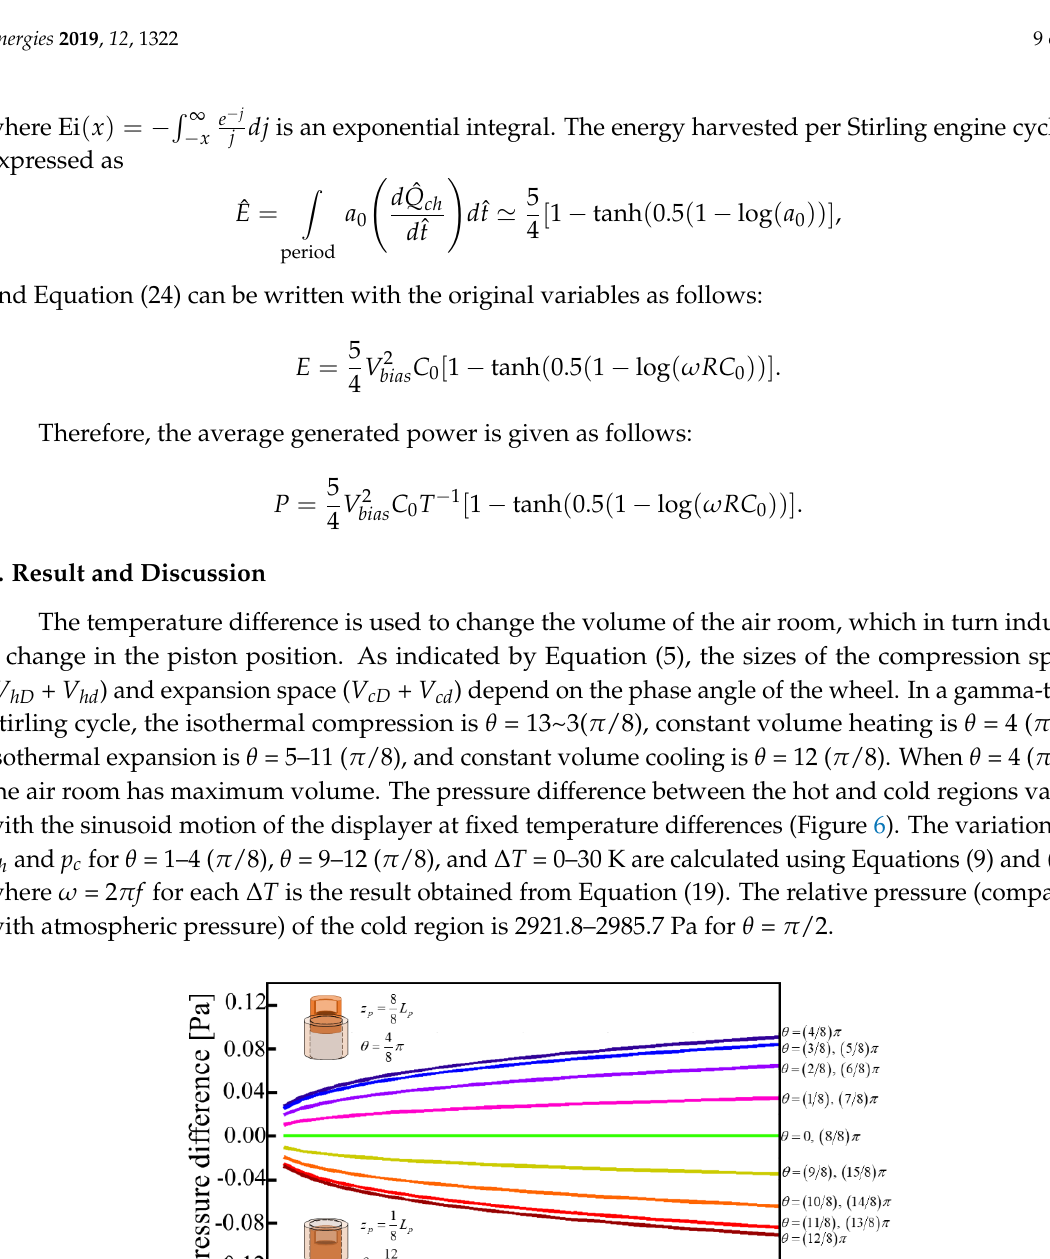
Figure 7. Relationship between the temperature difference of the Stirling engine and the frequency of the wheel. Small circles represent the experimental data, solid line the simulation data, and dotted line the fitting line with the cubic equation. As displayed in Figure 7, the triggered temperature difference of the Stirling engine is at least 12 K because the engine must overcome the friction and mass of the mechanical system ( M 1 , M 2 , M s , M c , and M wheel ). The activated resistance force is [ M 1 + μ k ( M 2 + M s + M c + M wheel )] g = 0.1731 N. Furthermore, through Equation (10), the difference in the pressures at 293 ( P 0 ) and 305 ( P 12 ) K is calculated to be 27.4 Pa for θ = 0. The pressure on the displacer is equal to 0.1743 N.